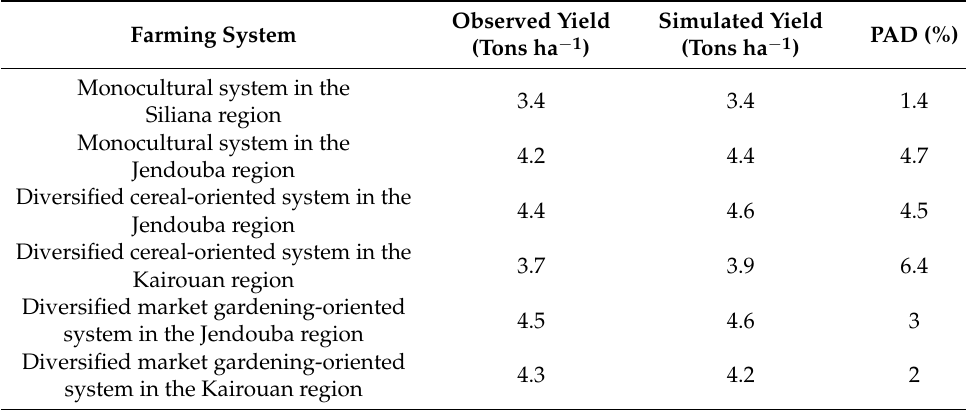
Table 3. Calibration of CROPSYST for each farming system.